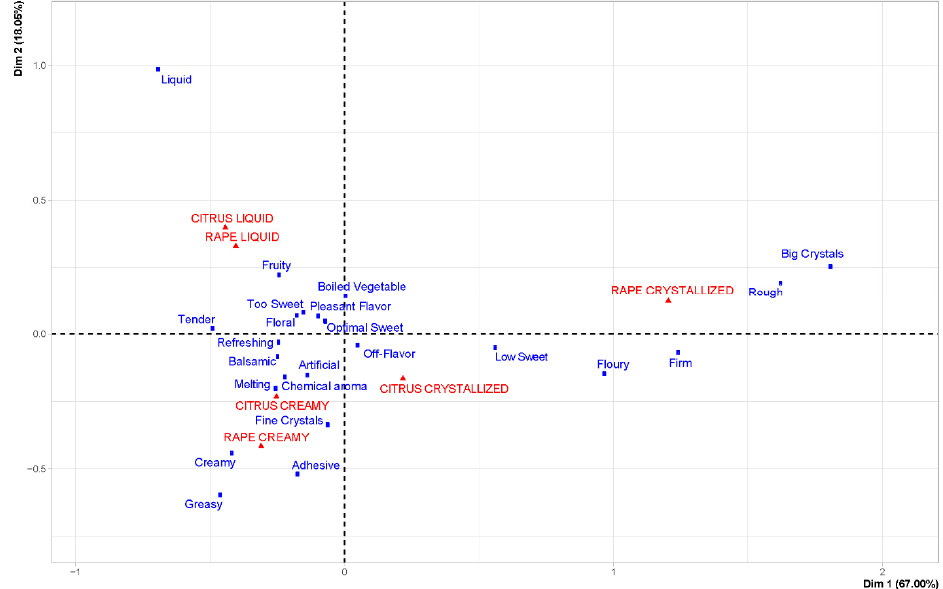
Figure 8. CA of gustatory CATA terms and the six honeys evaluated. Only statistically significant terms were used.